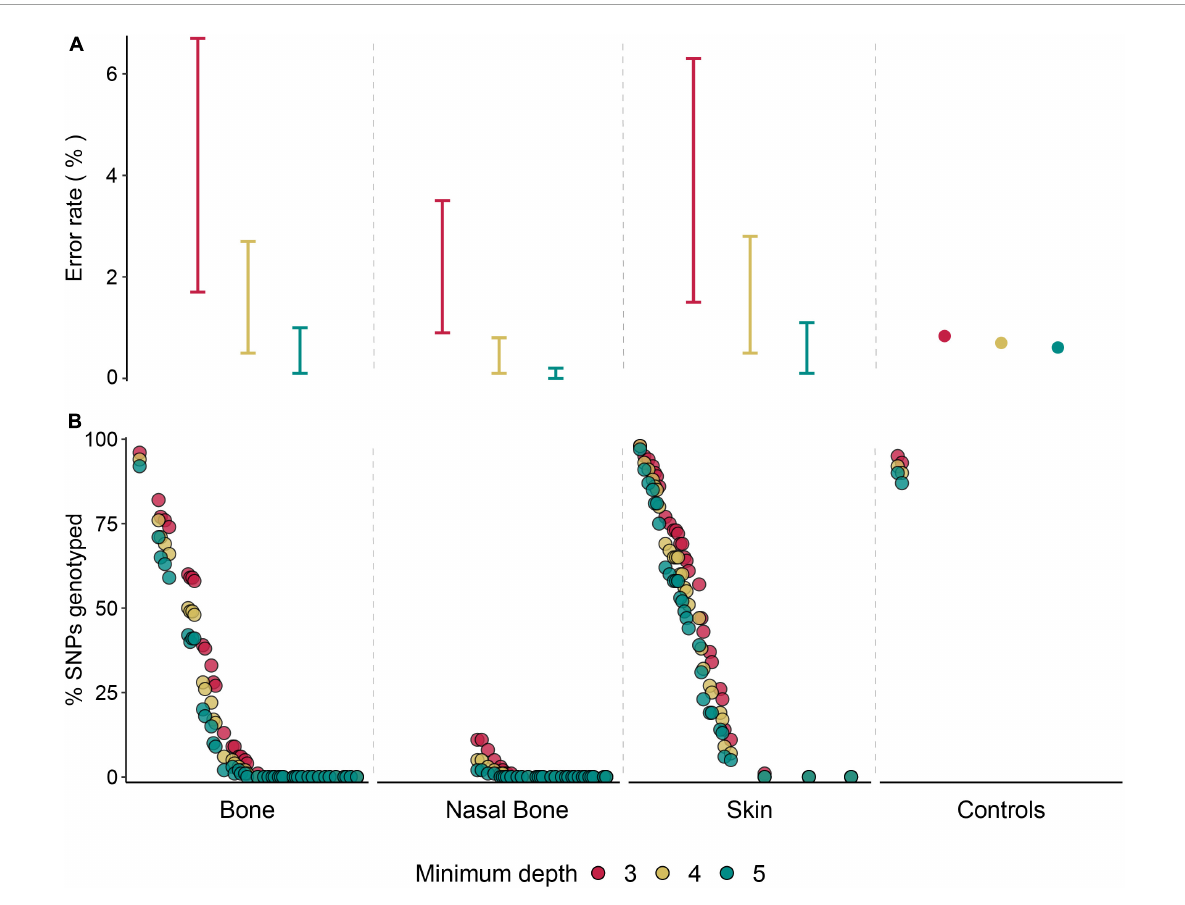
FIGURE3 Genotyping performance of hDNA from three sample types. (A) Interval of potential genotyping error rate estimates (%) for the three hDNA sample types, and average empirical genotyping error rate for control samples, considering the three minimum depth levels. (B) Percentage of genotyped SNPs ( N = 99,982) considering a minimum depth of 3x, 4x, or 5x per SNP across 103 samples. Each dot represents a